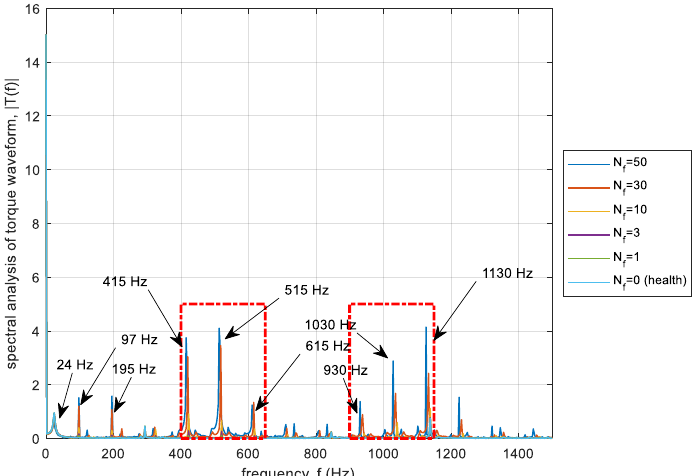
Figure 12. Spectral analysis of the torque waveform of a faulty motor, at T L = 15 Nm. Energies 2020 , 13 , x FOR PEER REVIEW